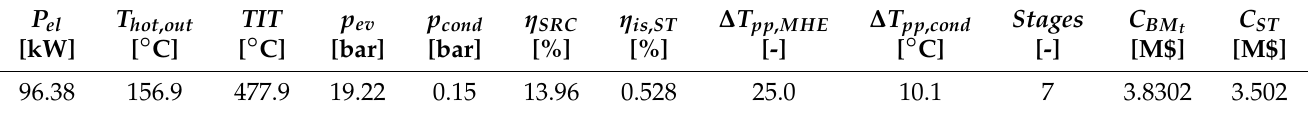
Table A4. Results of the thermodynamic optimization and economic analysis of the SRC without thermal loop. P el T hot , out